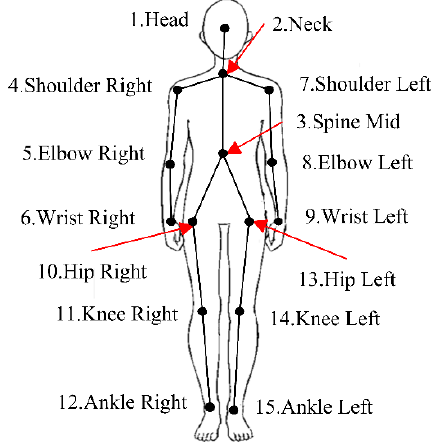
Figure 2. The 15 skeleton joints select in our methods.